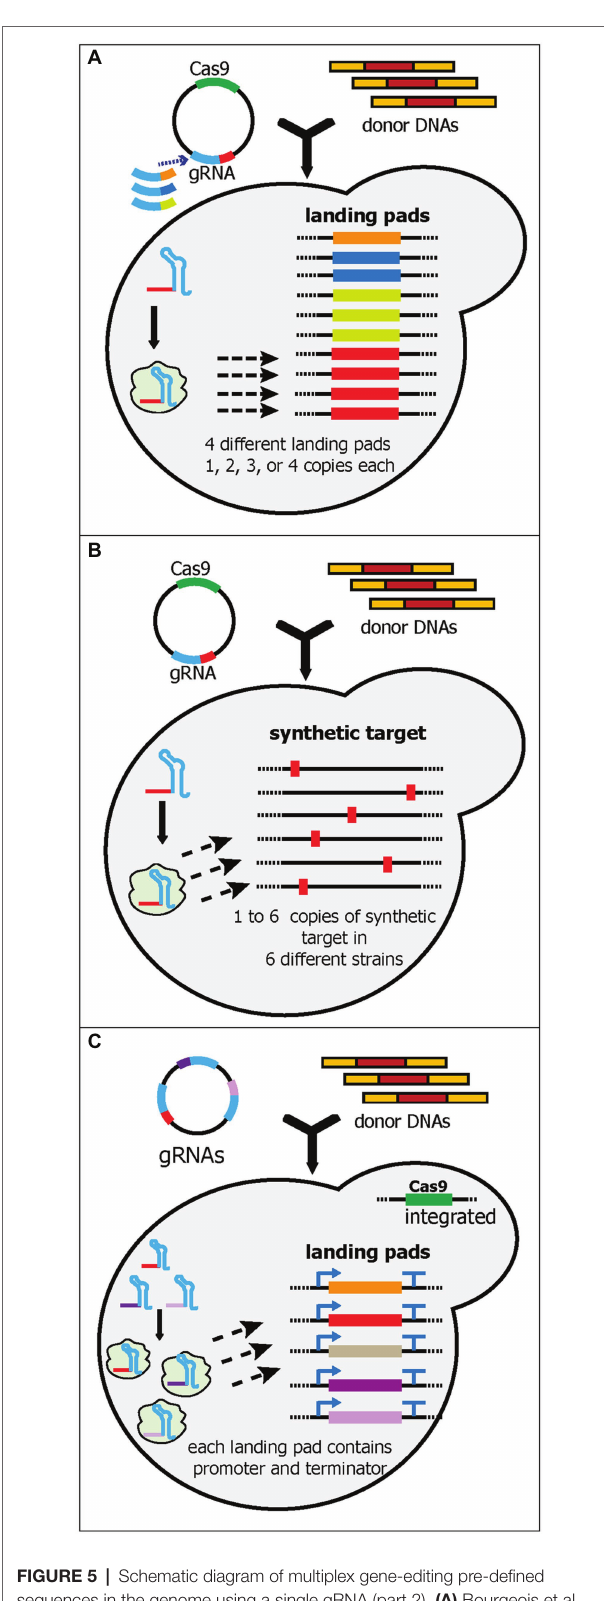
FIGURE 5 | Schematic diagram of multiplex gene-editing pre-defined sequences in the genome using a single gRNA (part 2). (A) Bourgeois et al.